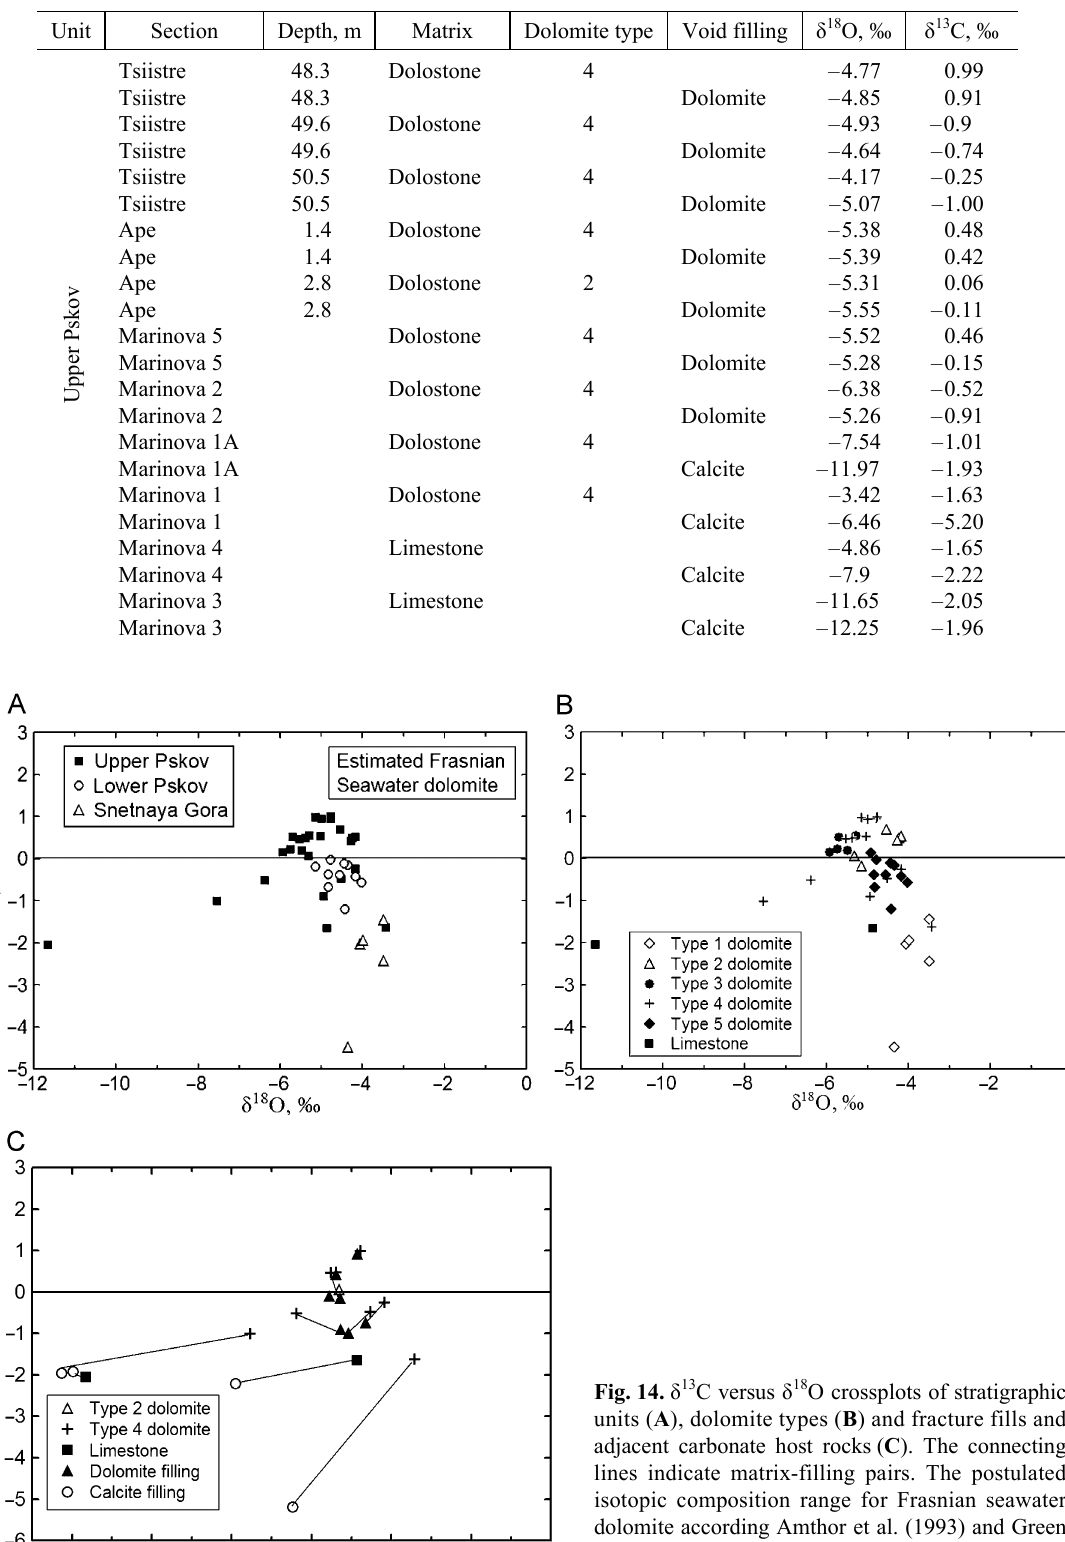
Fig. 14. δ 13 C versus δ 18 O crossplots of stratigraphic units ( A ), dolomite types ( B ) and fracture fills and adjacent carbonate host rocks ( C ). The connecting lines indicate matrix-filling pairs. The postulated isotopic composition range for Frasnian seawater dolomite according Amthor et al. (1993) and Green & Mountjoy